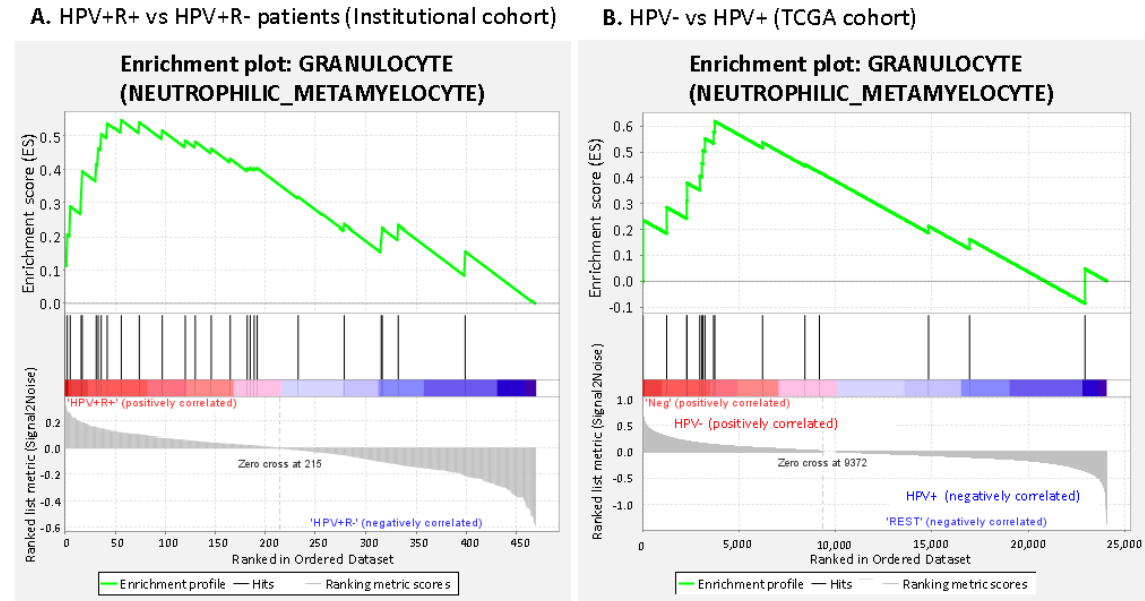
Figure 6. Enrichment of myeloid progenitor cell expression profiles is demonstrated in aggressive OPSCC tumors. ( A ). GSEA analysis revealed enrichment of myeloid progenitor cell expression (neutrophilic metamyelocyte) in the HPV+R+ patients when compared to HPV+R- patients ( p = 0.0, FDR q-value 0.004, FWER p -value = 0.03). ( B ). In the TCGA cohort, HPV- patients were correlated with enriched myeloid progenitor cell signatures when compared to HPV+ patients ( p = 0.0, FDR q-value 0.0052).